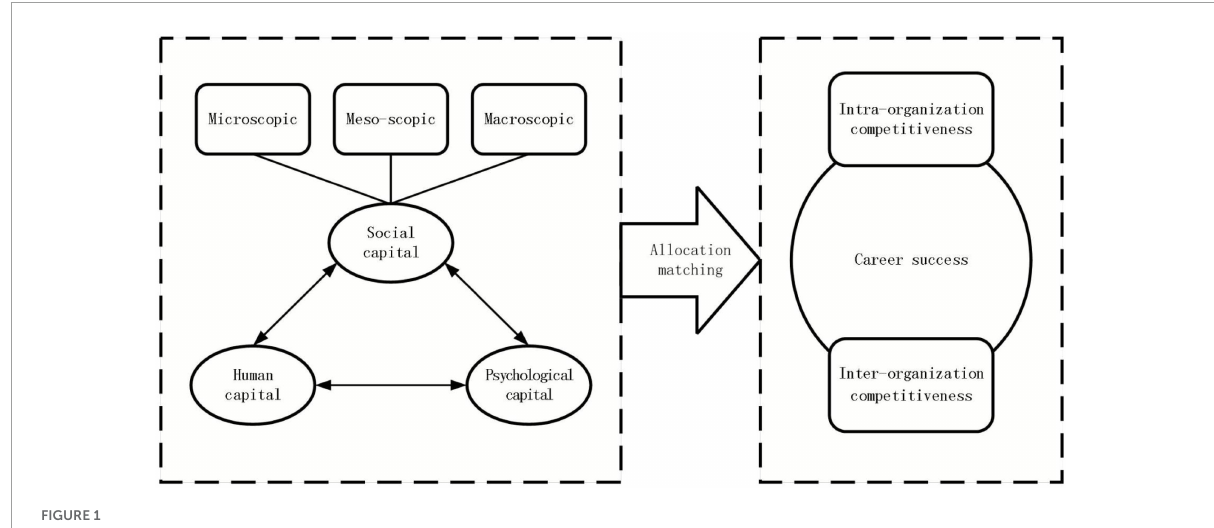
FIGURE1 Theoretical